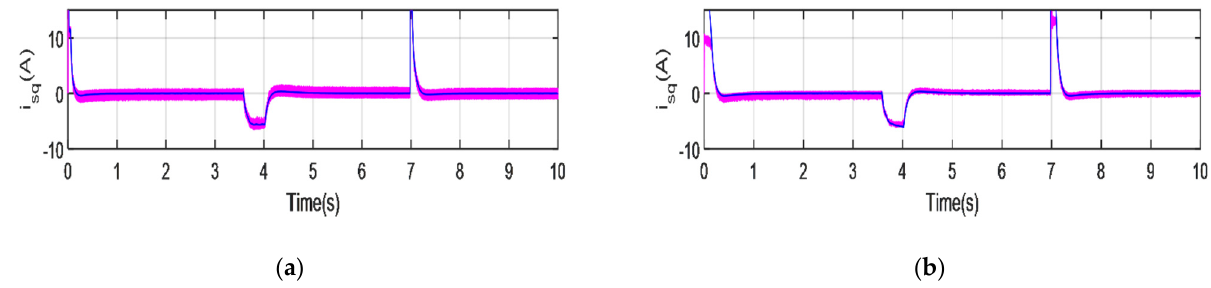
Figure 22. Isq components: ( a ) conventional inverter; ( b ) five-level inverter.